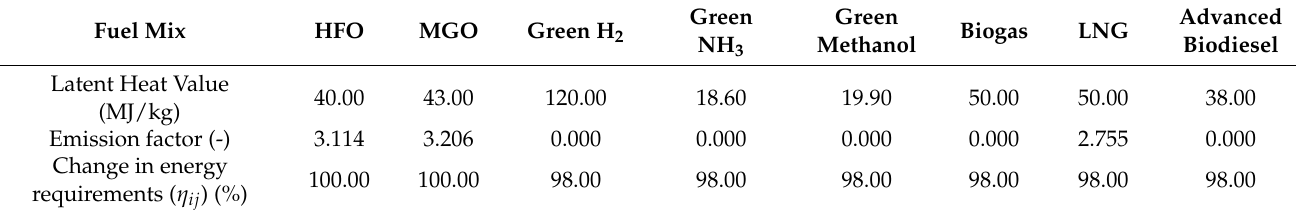
Table 4. Fuel parameters that were used in the scenarios of this work.